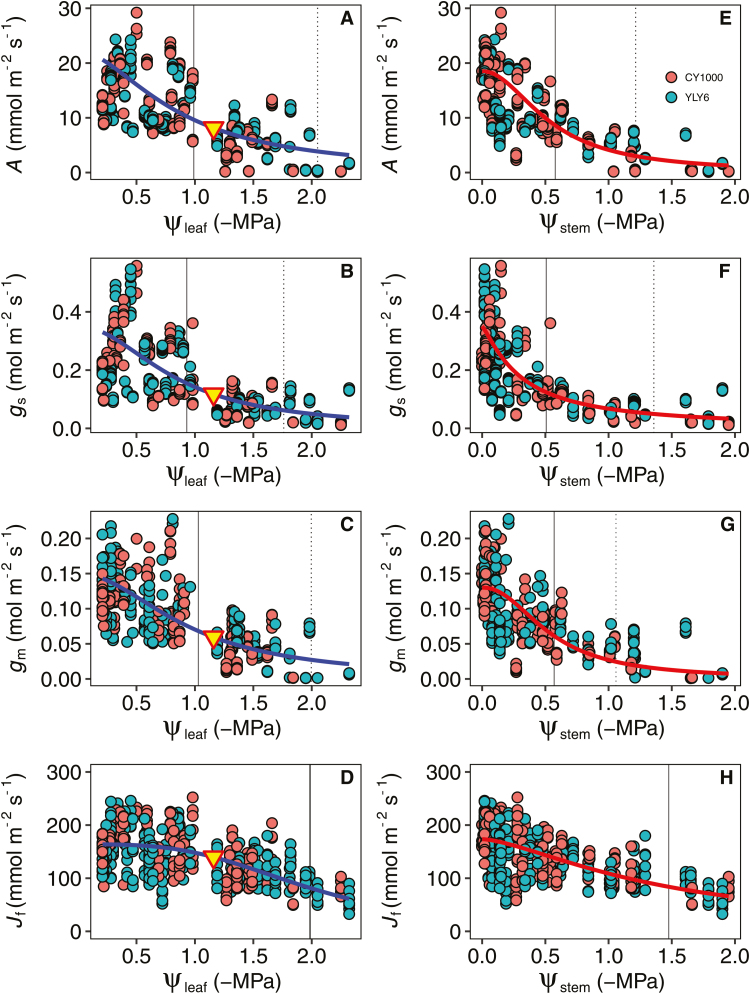
Response of the gas exchange parameters to decreasing (A–D) leaf water potentials (ψleaf) and (E–H) stem water potentials (ψstem). The vertical solid and dotted lines indicate the water potential at 50% and 80% loss of function, respectively. The triangle represents the turgor loss point (Table 1). Fitted lines are the best-fit functions selected using maximum likelihood.